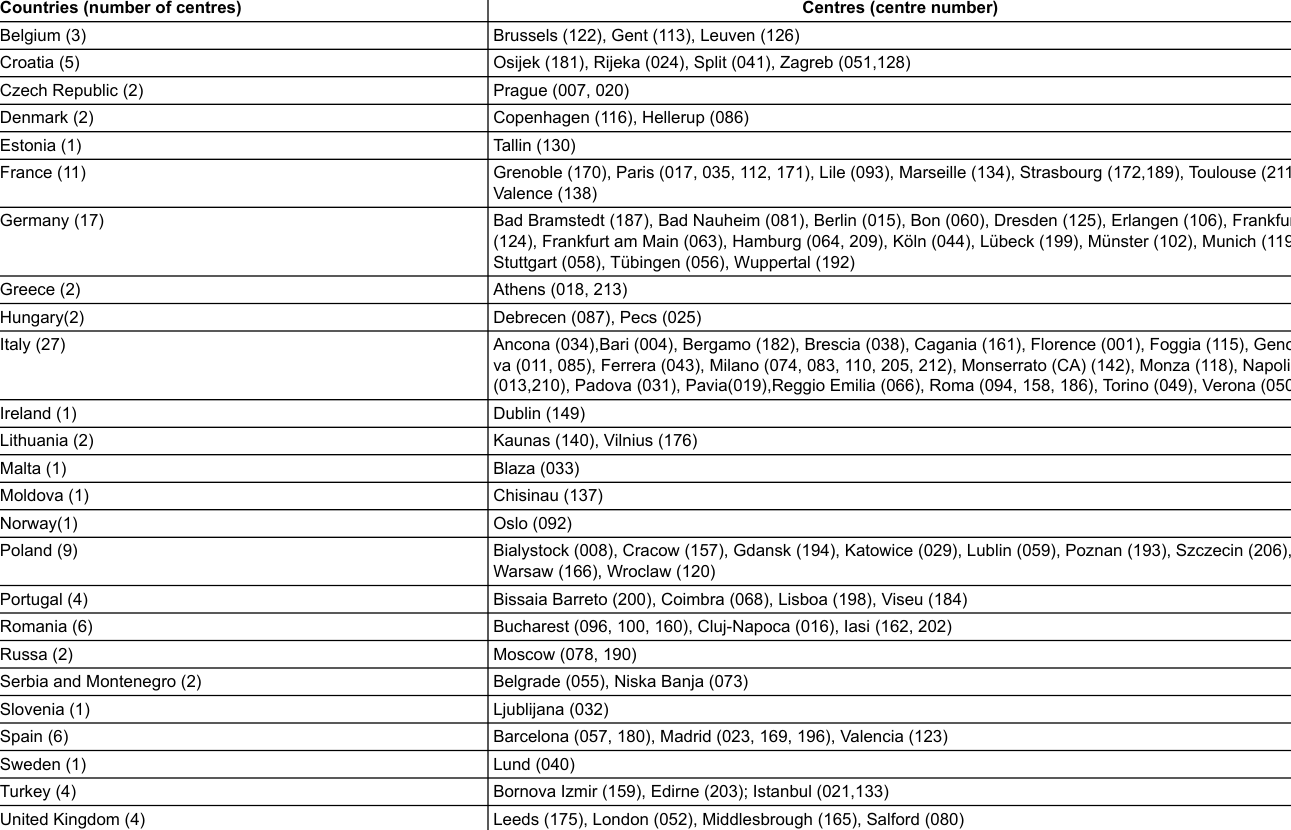
Table S1: List of all included European